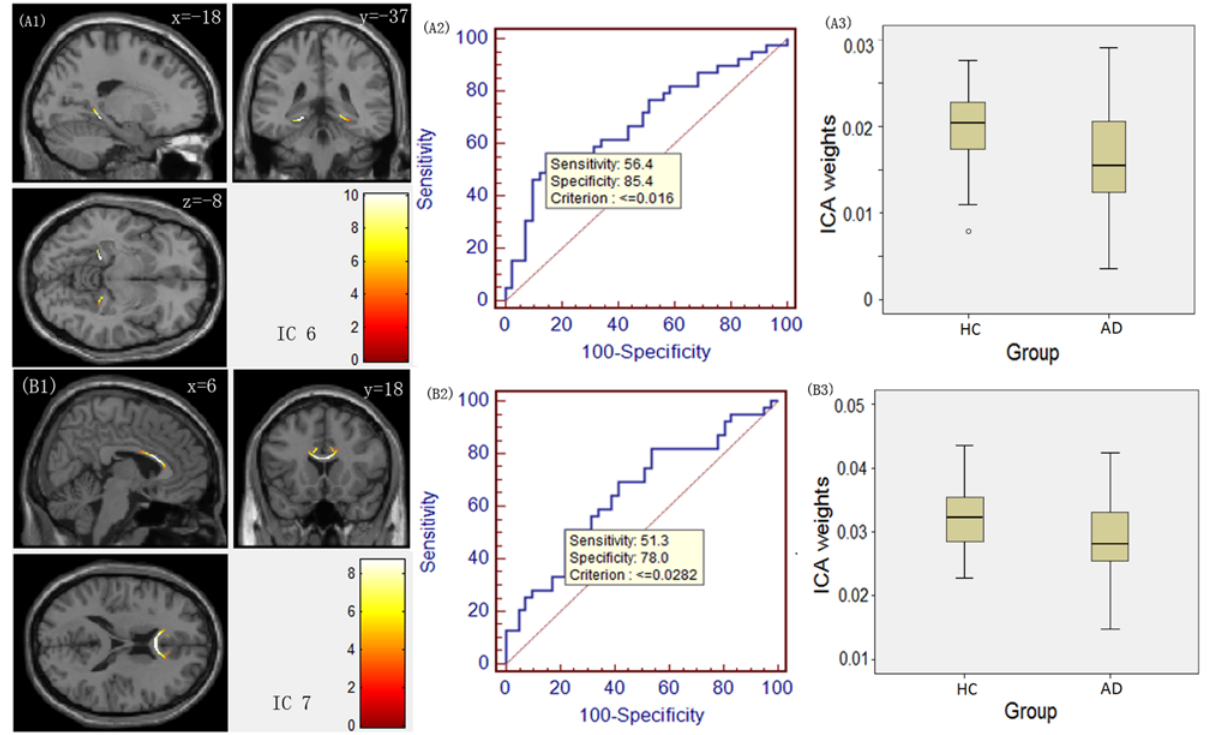
Fig 3. IC spatial maps displaying the covariant FA changes in white matter in AD patients compared to HCs for ICs 6 and 7. The colour bar represents Z-score. The middle panel displays their corresponding receiver operating characteristic (ROC) curve, and the right panel displays a boxplot of the between-group differences in ICA